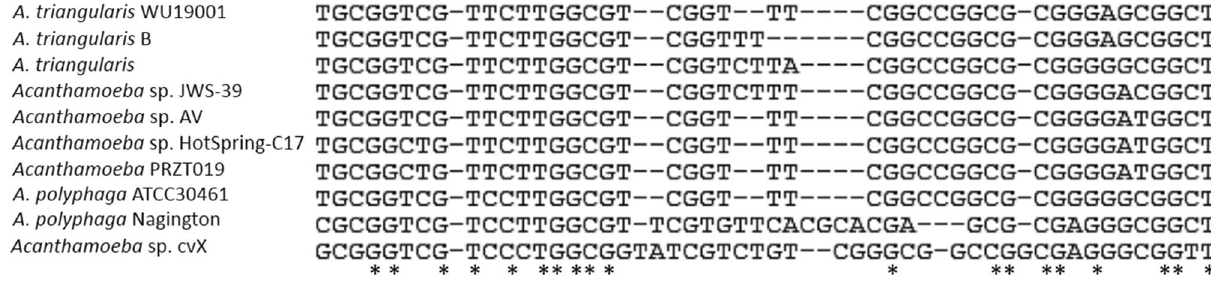
Figure 1. Primary sequence alignment of the DF3 region using CLUSTAL W. The region shown a subset of the total DF3 region which demonstrates the highest variation. Asterisks denote similarities and dashes denote gaps within the nucleotide